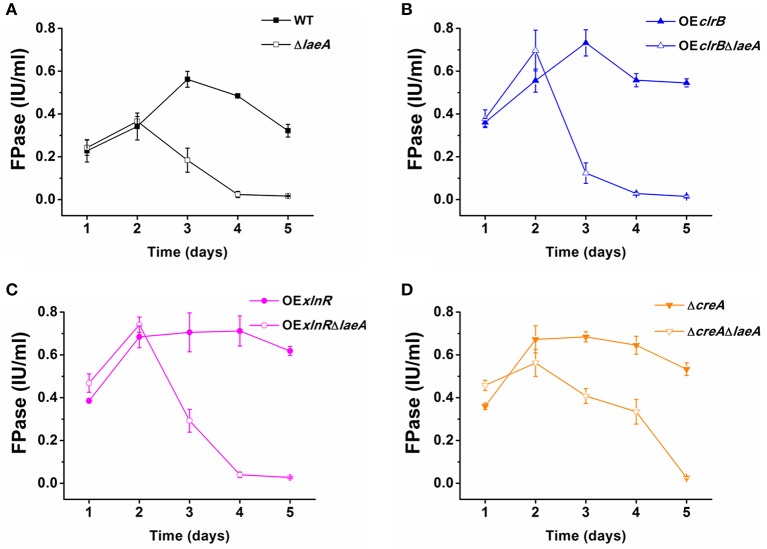
Cellulolytic activity assay of WT and various mutants. The strains were cultivated in liquid Vogel's salts medium supplemented with 1% wheat bran and 1% microcrystalline cellulose as carbon resources to induce cellulase gene expression. The strains were cultivated at 30°C for 5 days. FPA, a measure of the combined activities of both endo- and exo-type cellulases, was determined by hydrolyzing a strip of filter paper (Whatman #1, 50 mg, 1 cm × 6 cm) for 1 h at 50°C. (A) FPA of WT and ΔlaeA. (B) FPA of OEclrB and OEclrBΔlaeA. (C) FPA of OExlnR and OExlnRΔlaeA. (D) FPA of ΔcreA and ΔcreAΔlaeA. The values show the mean of three biological replicates, and the error bar indicates the standard deviation.